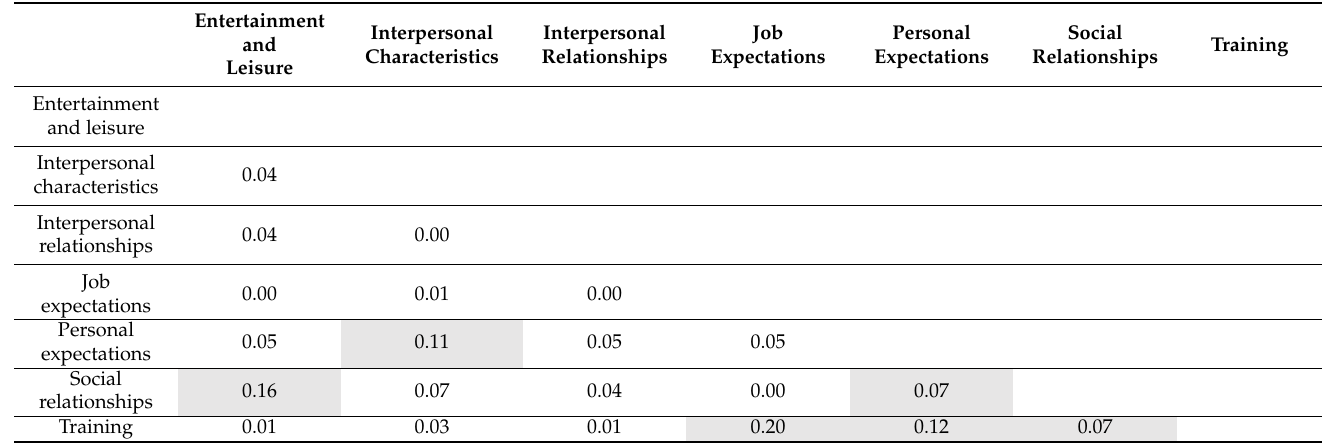
Table 1. Table of co-occurrence between emerging